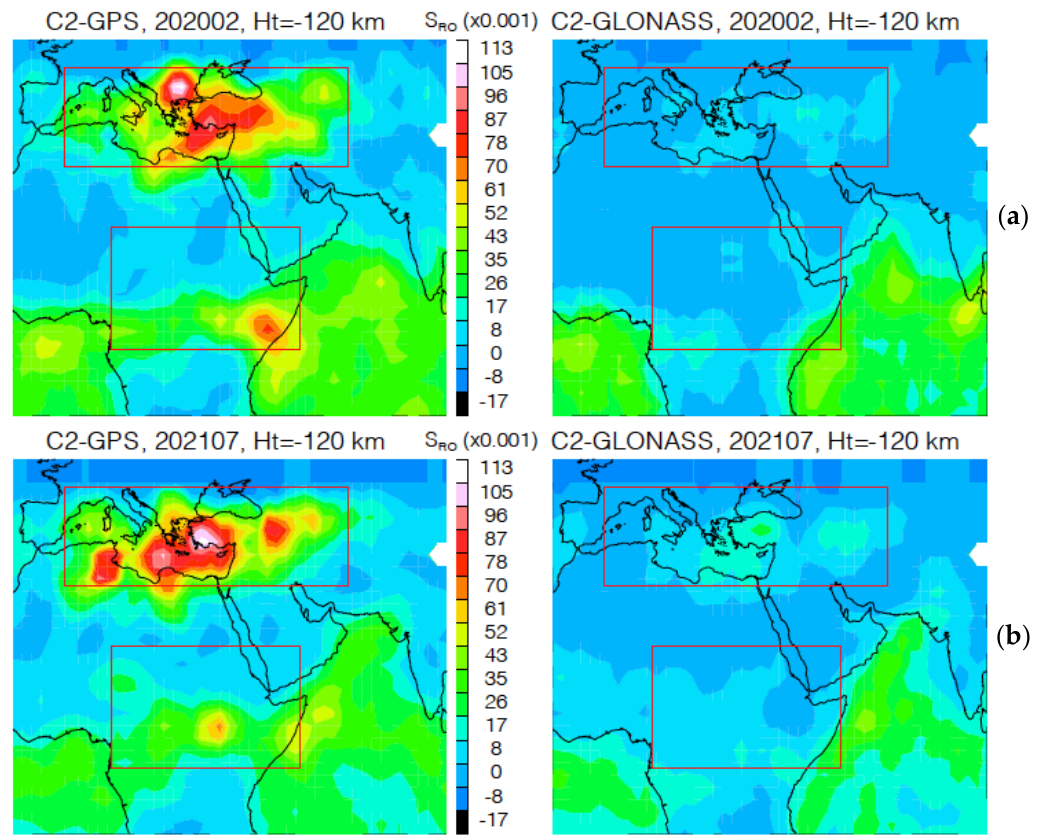
Figure A11. Comparisons of GPS and GLONASS jamming signals as observed in the COSMIC-2 nighttime S RO at H SL = −120 km over the Mediterranean Sea and Middle East (MSME) and Central Africa (CA) from ( a ) February 2020 and ( b ) July 2021. The MME and CA regions are indicated by the red boxes on the maps.